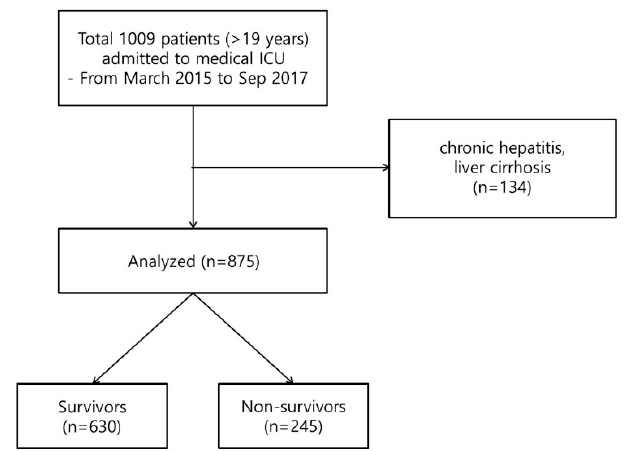
Figure 1. Flowchart of the inclusion and exclusion process for enrollment of patients in the study. ICU: intensive care unit. A total of 1009 patients were enrolled, and 875 patients were included in the analysis.